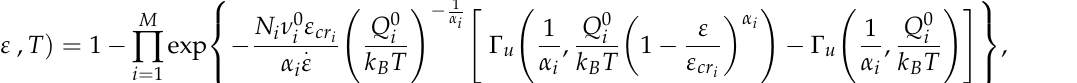
We can now address the activation parameters in the obtuse angle (site type number